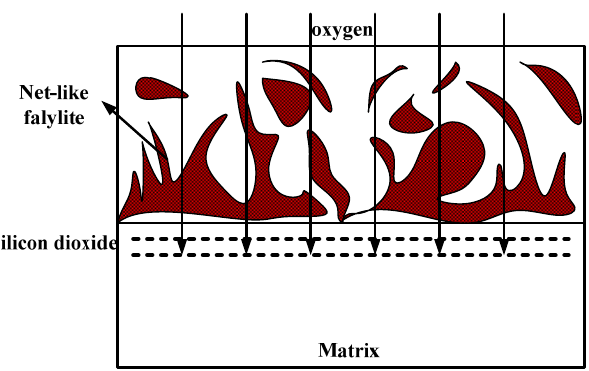
Figure 9. The schematic diagram of the formation of granular silicon dioxide in iron matrix.